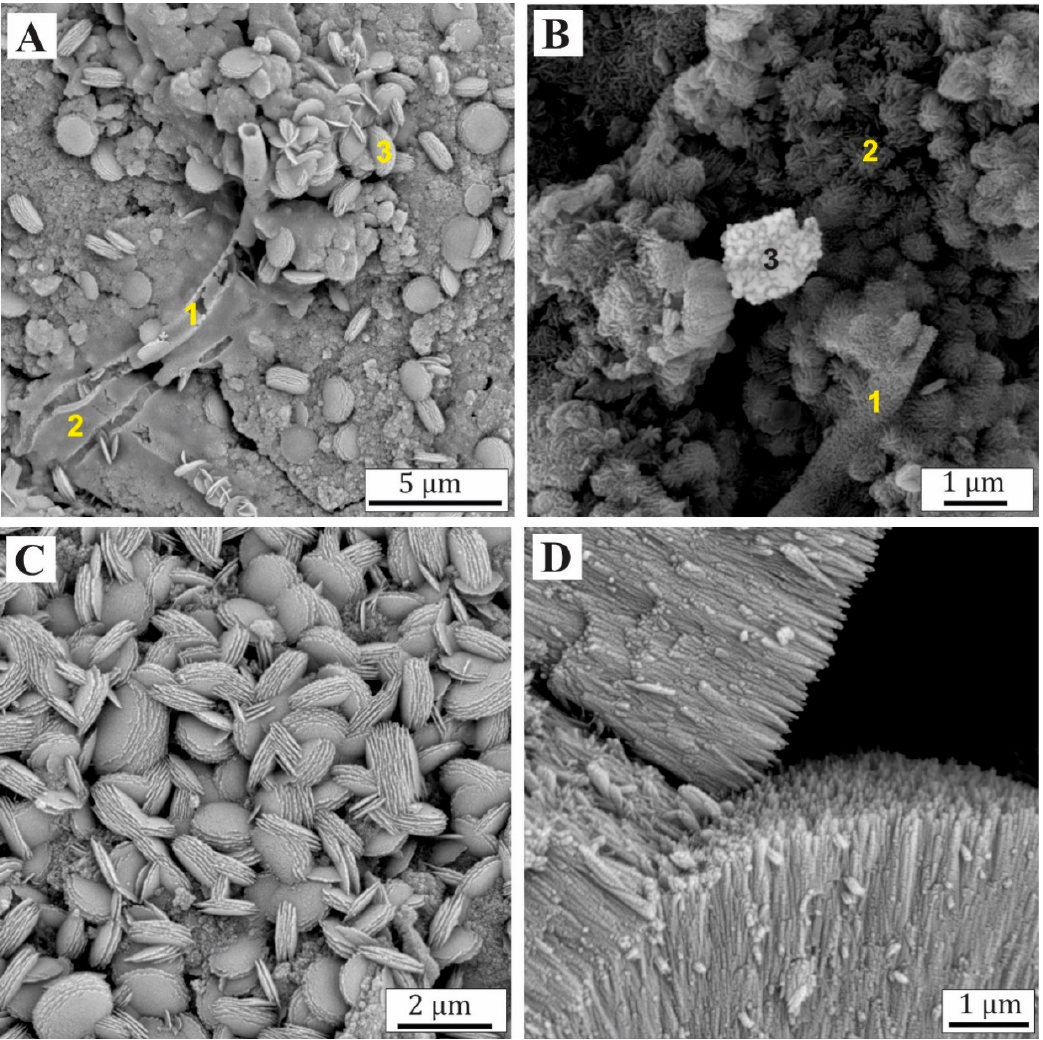
Figure 7. (A-D) SEM micrographs of internal surface of a broken ferruginous pisolith formed in the Perkolilli Shale (PPS) showing morphologies of various minerals in core and cortex. (A) The core of a pisolith showing a ferruginized microfossil (1), organic coatings (2) and platy aggregates of radial crystals of goethite (3). (B) The core of a pisolith showing ferruginized microfossil (1) in a matrix of radial crystals of goethite (2). Gold grain (3). (C) High magnification micrograph of radial crystals of goethite. (D) The cortex of a pisolith showing oriented acicular crystals of goethite.